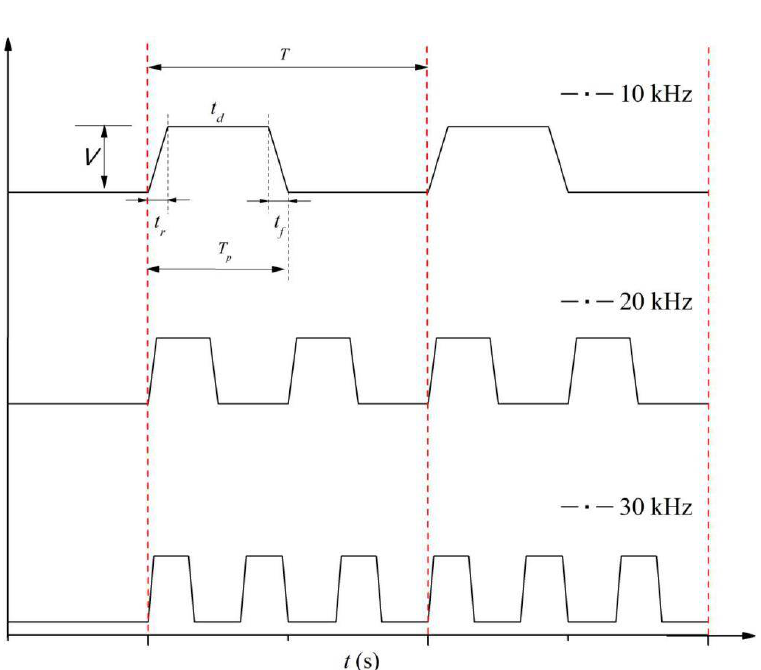
Figure 2. Schematic of periodic rectangle-wave pulse waveform.